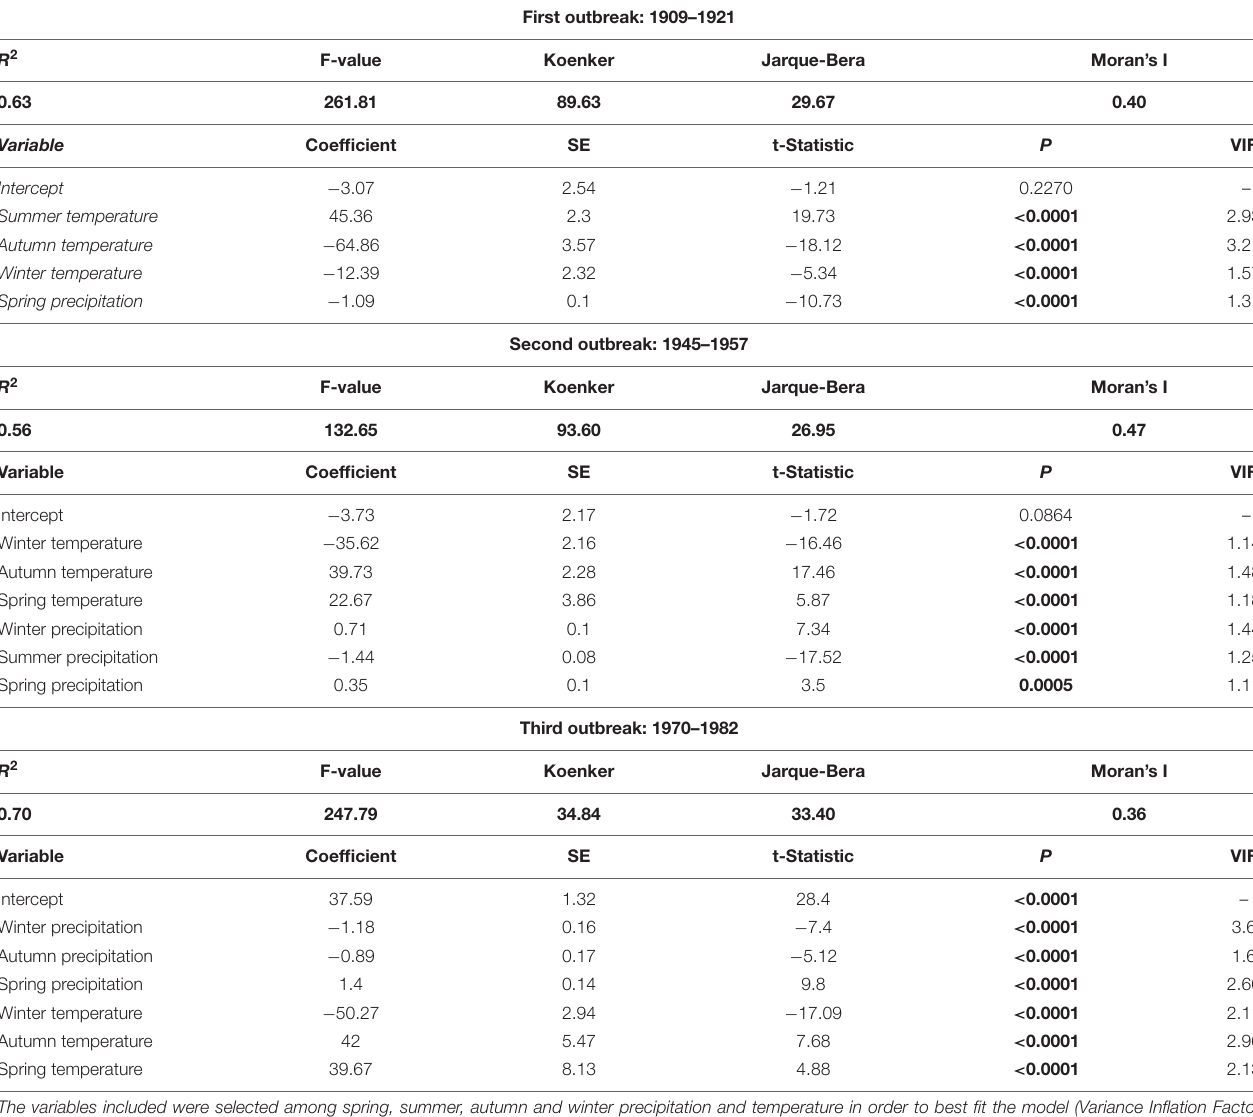
TABLE 2 | Ordinary Least Squares model for each outbreak period.